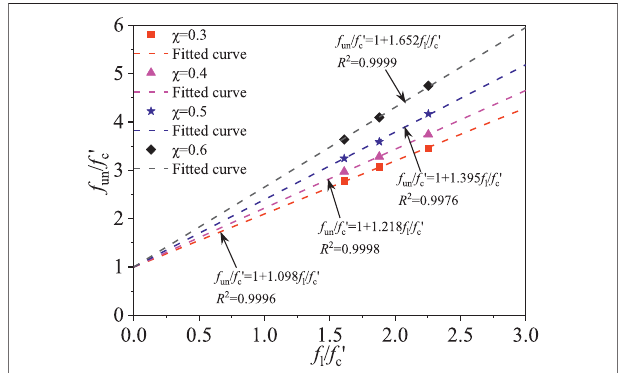
FIGURE 13 | Scatter diagram and fi tting results of f un / f c ’ - f l / f c ’ .